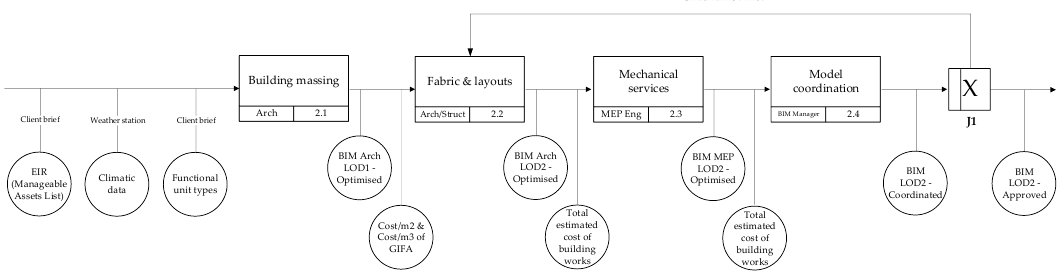
Figure 5. Mid-level (Level 2) IDEF3 decomposition of UOB 2.0 “Concept design”.